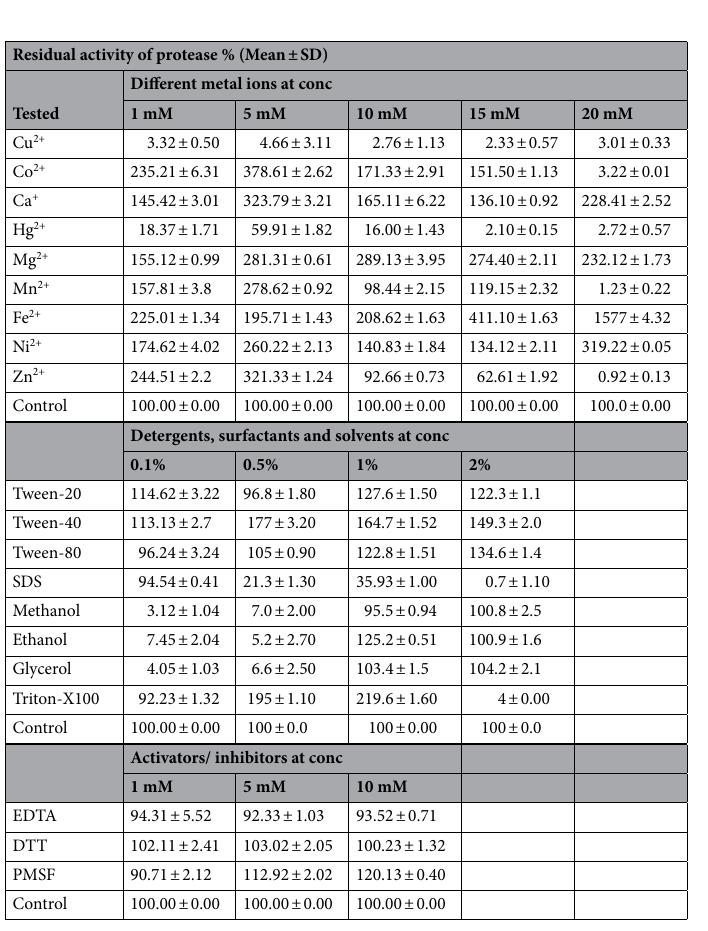
Table 5. Effect of different metal ions, detergents, surfactants, activators/inhibitors on the activity of the partially purified enzyme using the casein substrate and measured as protease.